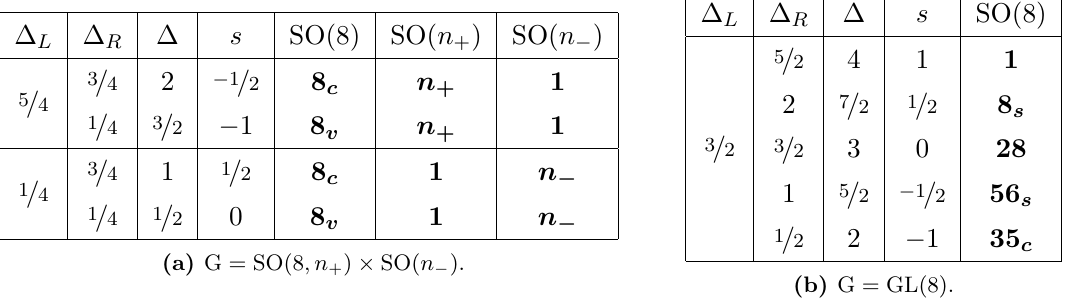
Table 4. Mass spectra for the OSp(8 the R -symmetry group. The spectrum organizes into multiplets of OSp(8 and table 7 of ref. [23], respectively. For non-vanishing (cid:18) pqrs , the factor SO( n a subgroup K 0 , and the representation n (cid:0) is replaced by the corresponding representation of K 0 . n = (cid:0)